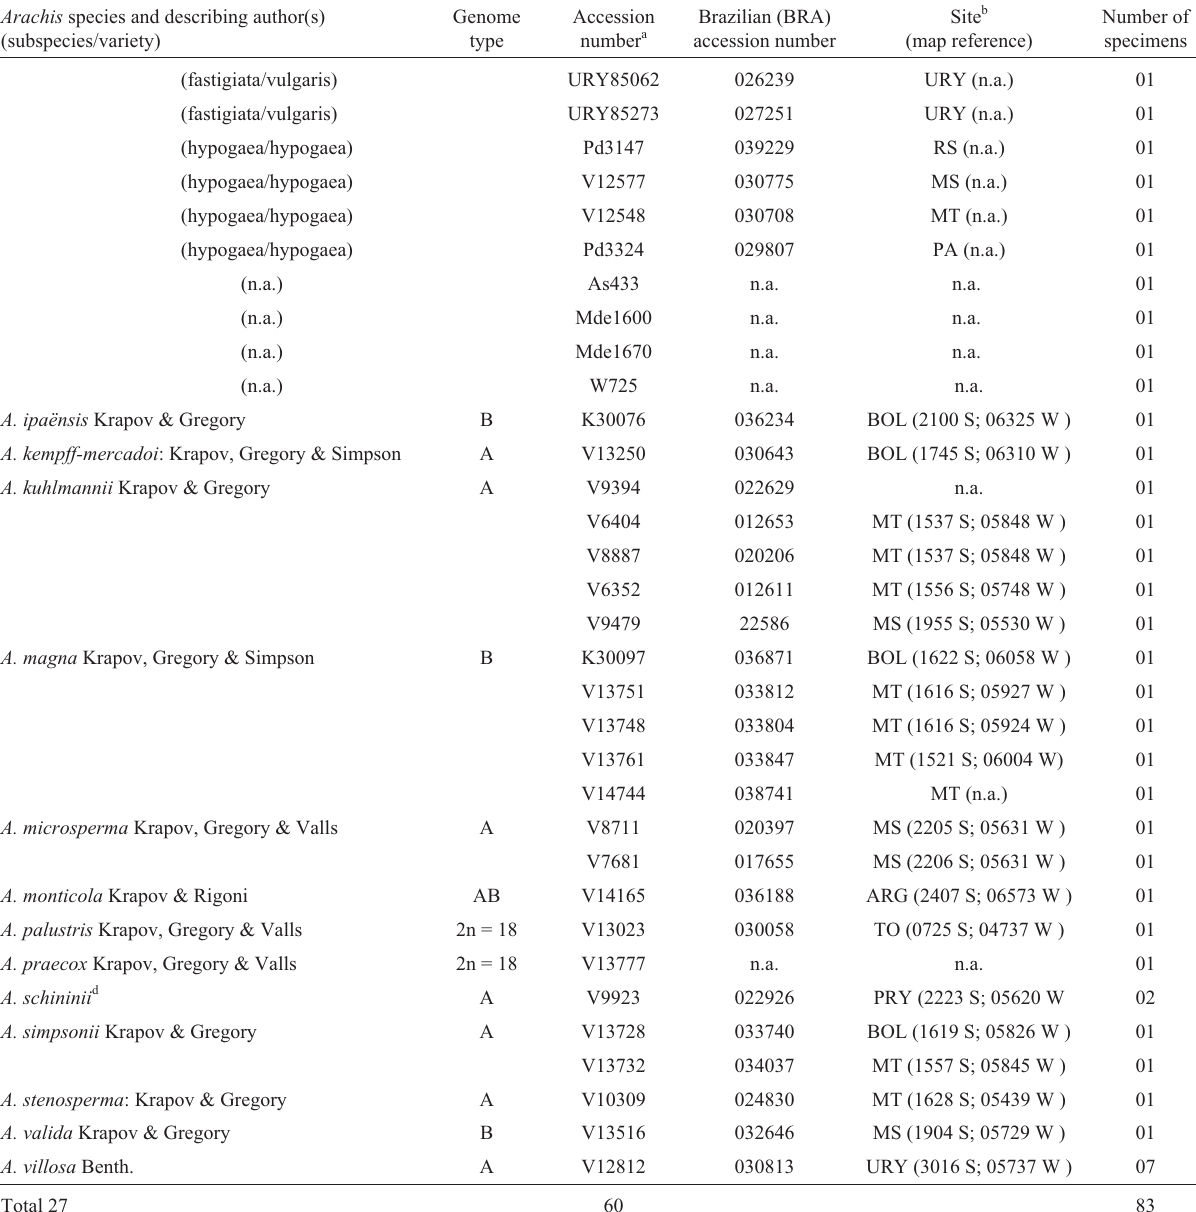
Table 1 (cont.) Arachis species and describing author(s)